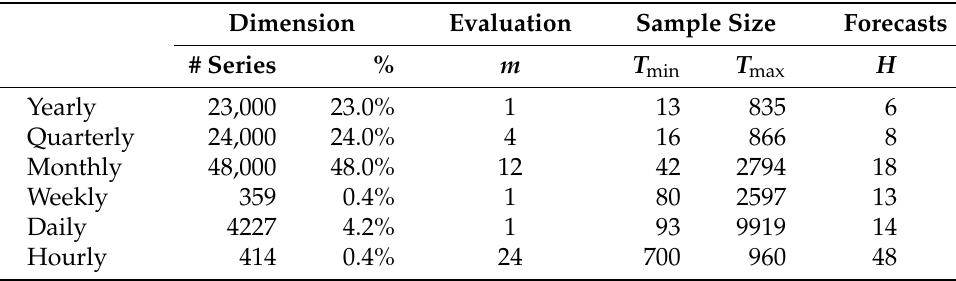
Table 1. Basic properties of the M4 data